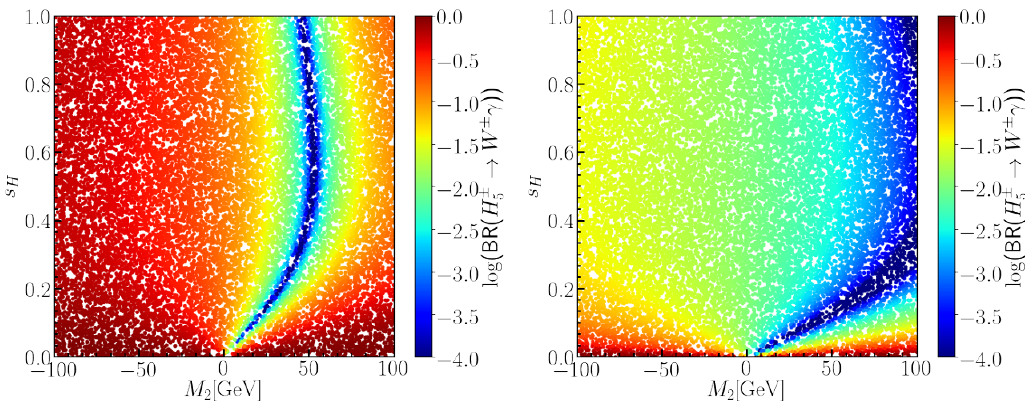
Figure 9 . Dependence of BR( H (cid:6) m 5 = 150 GeV